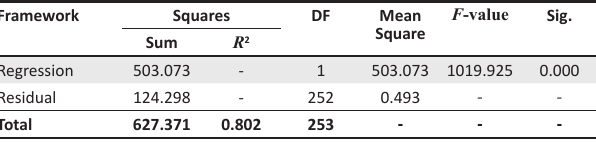
TABLE 4a: Influence of the intervening variable on customer loyalty. Framework